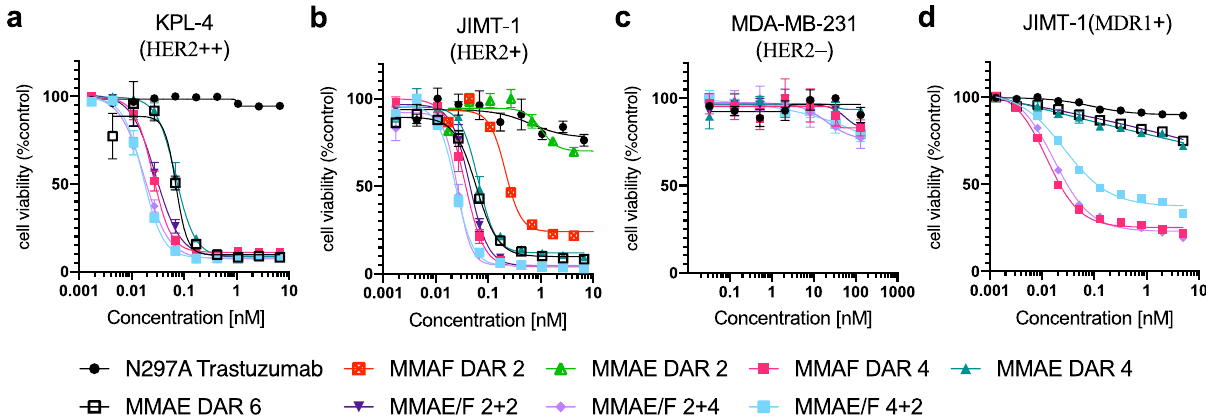
Fig. 3 In vitro cytotoxicity. a – d Cell killing potency in the breast cancer cell lines KPL-4 ( a ), JIMT-1 ( b ), MDA-MB-231 ( c ), and JIMT-1(MDR1 + ) ( d ). Unconjugated N297A trastuzumab (black circle), MMAF DAR 2 ADC (red square), MMAE DAR 2 ADC (light green triangle), MMAF DAR 4 ADC (magenta square), MMAE DAR 4 ADC (green triangle), MMAE DAR 6 ADC (black open square), MMAE/F 2 + 2 ADC (dark purple inversed triangle), MMAE/F 2 + 4 ADC (light purple diamond), and MMAE/F 4 + 2 ADC (cyan square). Concentrations are based on the antibody dose without normalizing to each DAR. All assays were performed in quadruplicate. Data are presented as mean values ± SEM ( n = 3 for N297A trastuzumab, MMAF DAR 4 ADC, and MMAE DAR 6 ADC in KPL-4, and MMAE DAR 2 and MMAE DAR 2 ADCs in JIMT-1; n = 4 for other groups). Source data are available as a Source Data fi le.